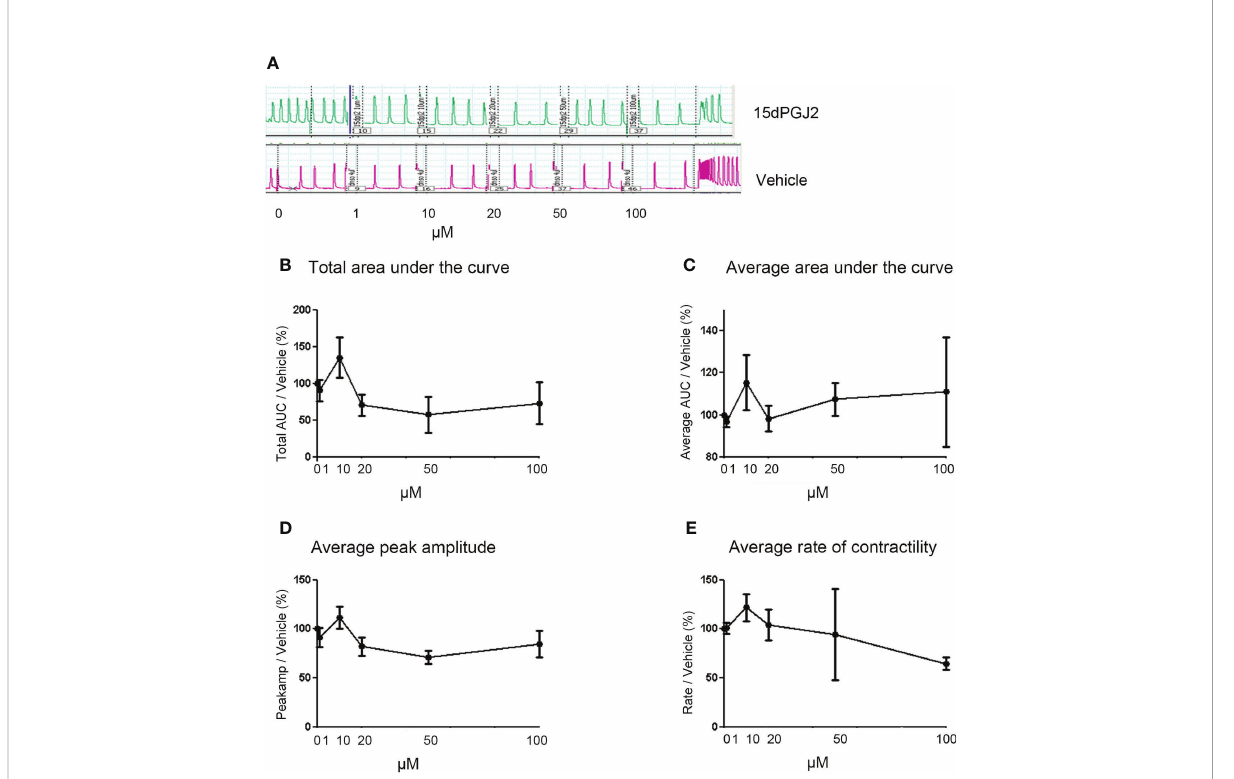
FIGURE 4 15dPGJ2 has no effect on myometrial contractility. Myometrial tissues biopsies were dissected and mounted on the myograph machine and stretched to 4g tension to achieve spontaneous contractions. After spontaneous contractions were established, the tissues were treated with 1, 10, 20, 50 and 100µM of 15dPGJ2 or vehicle control. A representative trace is shown for two 15dPGJ2 treated strips and a vehicle control strip (A) . A cumulative dose response with 15dPGJ2 or vehicle was performed and the effect on total and average area under the curve (B, C) , peak amplitude (D) and rate of contractility (E) was determined. 15dPGJ2 had no signi fi cant effect on myometrial contractility. V = vehicle. n = 3 biological replicates, each containing at least two 15dPGJ2 treated strips per biological replicate. Data are presented as mean ±